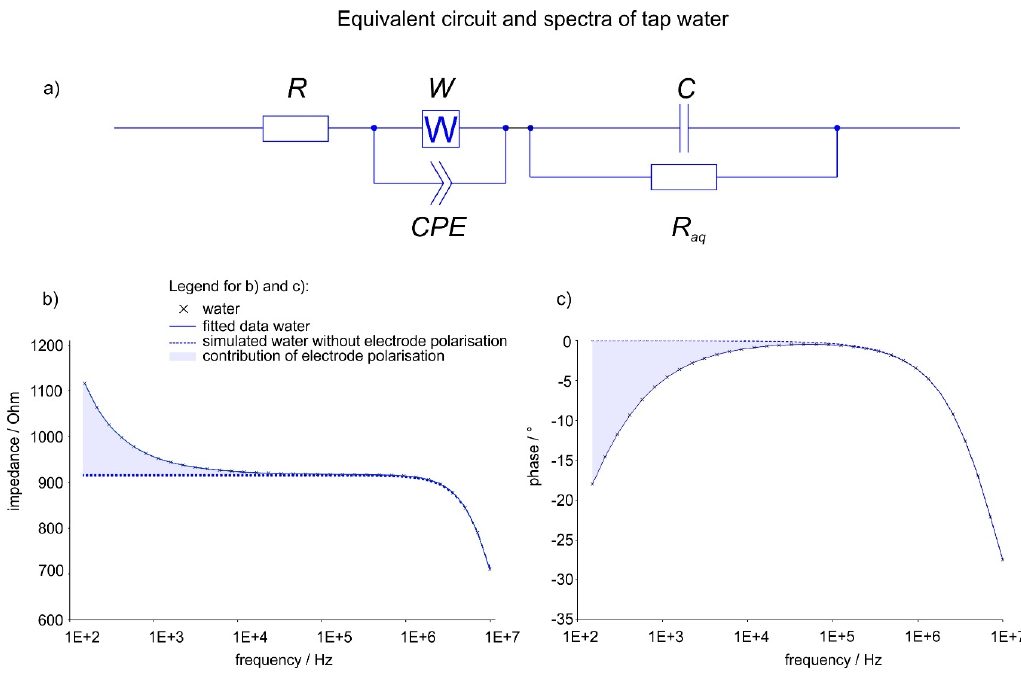
Figure 1. ( a ) Equivalent circuit; ( b ) exemplary impedance Z ; ( c ) phase spectra ( φ , subfigure c) of tap water incl. fitting results. R , W and CPE are resistance, Warburg impedance and constant phase element simulating electrode polarization and ion migration; C and R aq the capacitance and resistance of tap water.